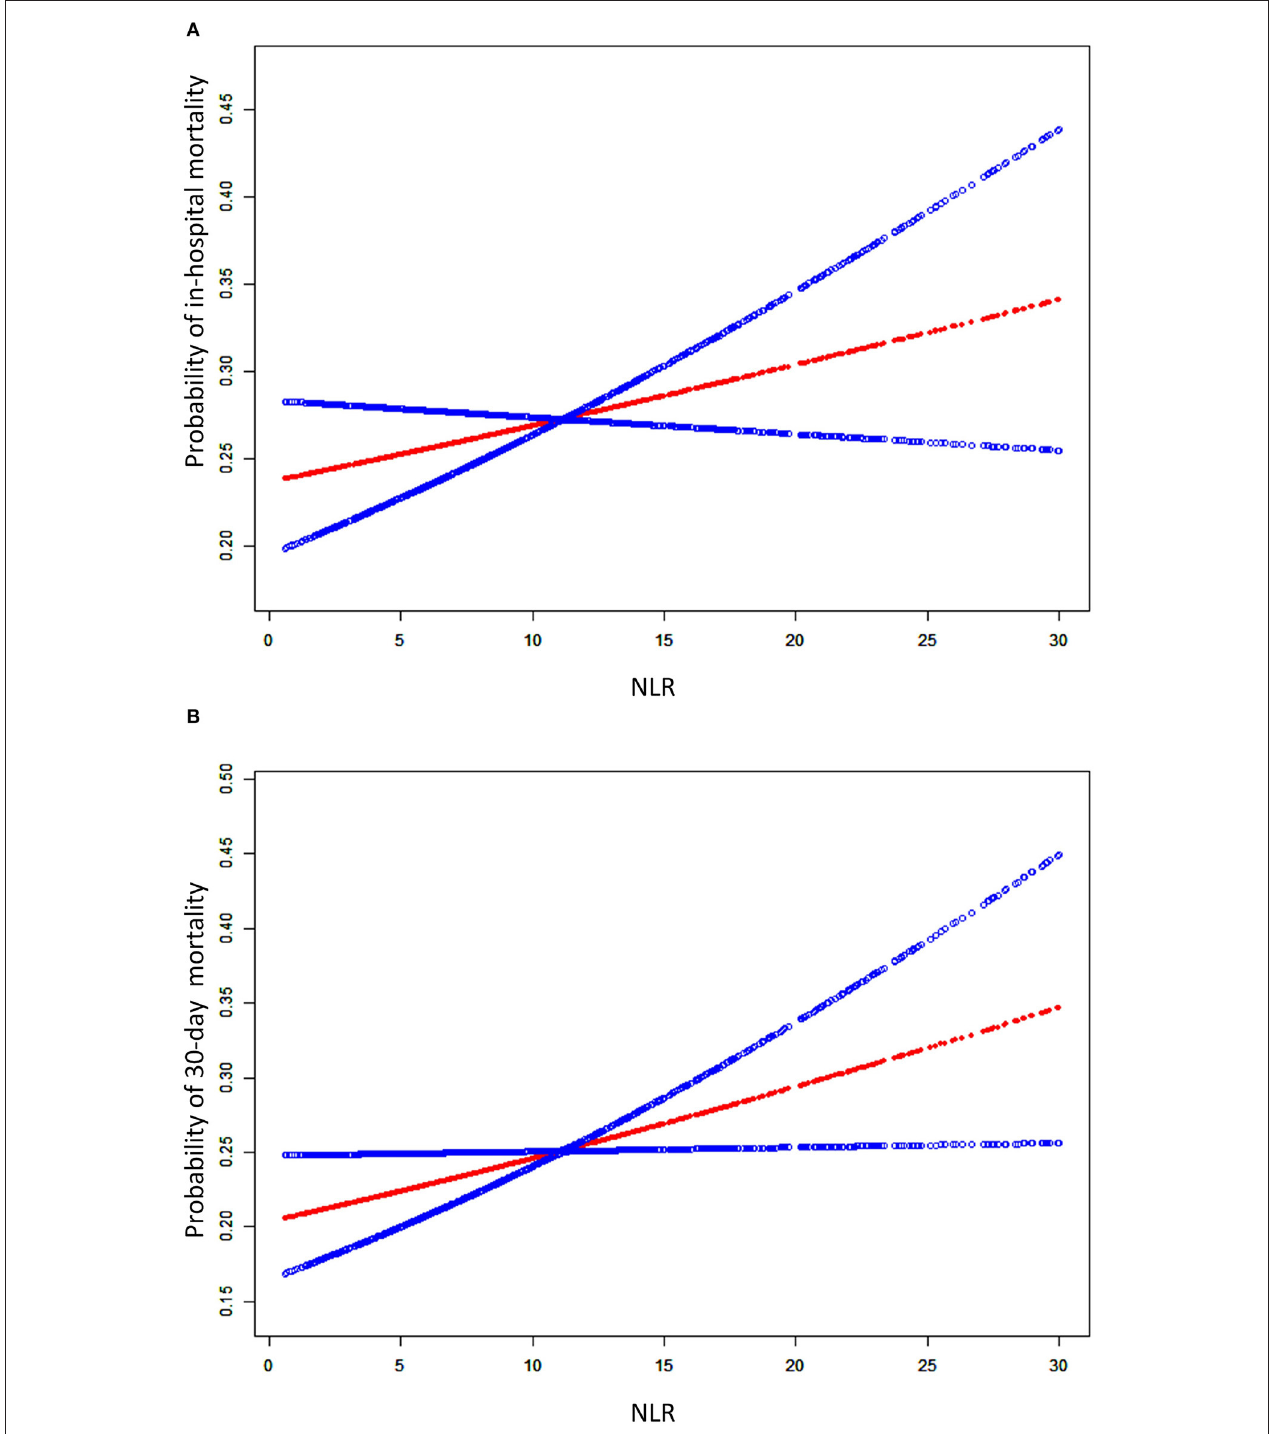
FIGURE 2 | A smooth curve fitting for the relationship between the baseline NLR and the risk of in-hospital mortality (A) and 30-day mortality (B) . The resulting figures show the risk of mortality in the y-axis and the NLR (continuous variable) in the x-axis. The red line shows the dose-response curve between NLR and probability of short-term mortality, the two blue lines refer to 95% CIs. A positive relationship between NLR and the risk of short-term mortality was observed after adjusting for age, gender, ethnicity, smoking, admission type, COPD, hypertension, tumor, diabetes mellitus, renal failure, SID30, pneumonia, sepsis, aspiration, trauma/surgery, other non-pulmonary, PaO 2 /FiO 2 , SAPS II, OASIS, SOFA, corticosteroids therapy, antibiotic therapy, vasopressor therapy, ventilation received, and renal replacement therapy by spline smoothing plot.